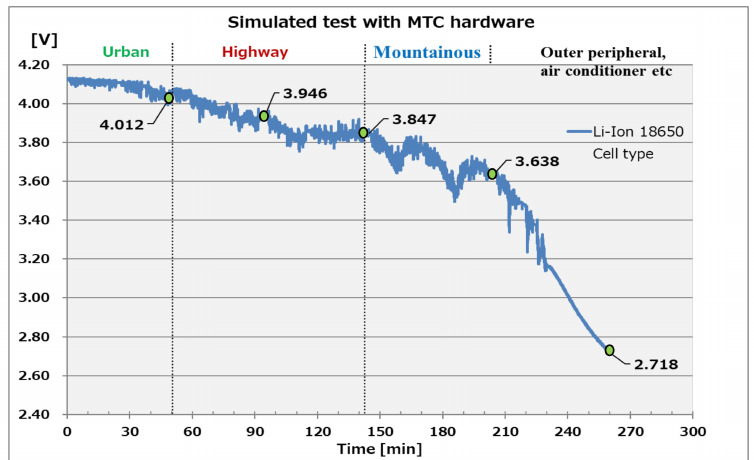
Figure 18. Battery pack voltage during EV’s driving test.